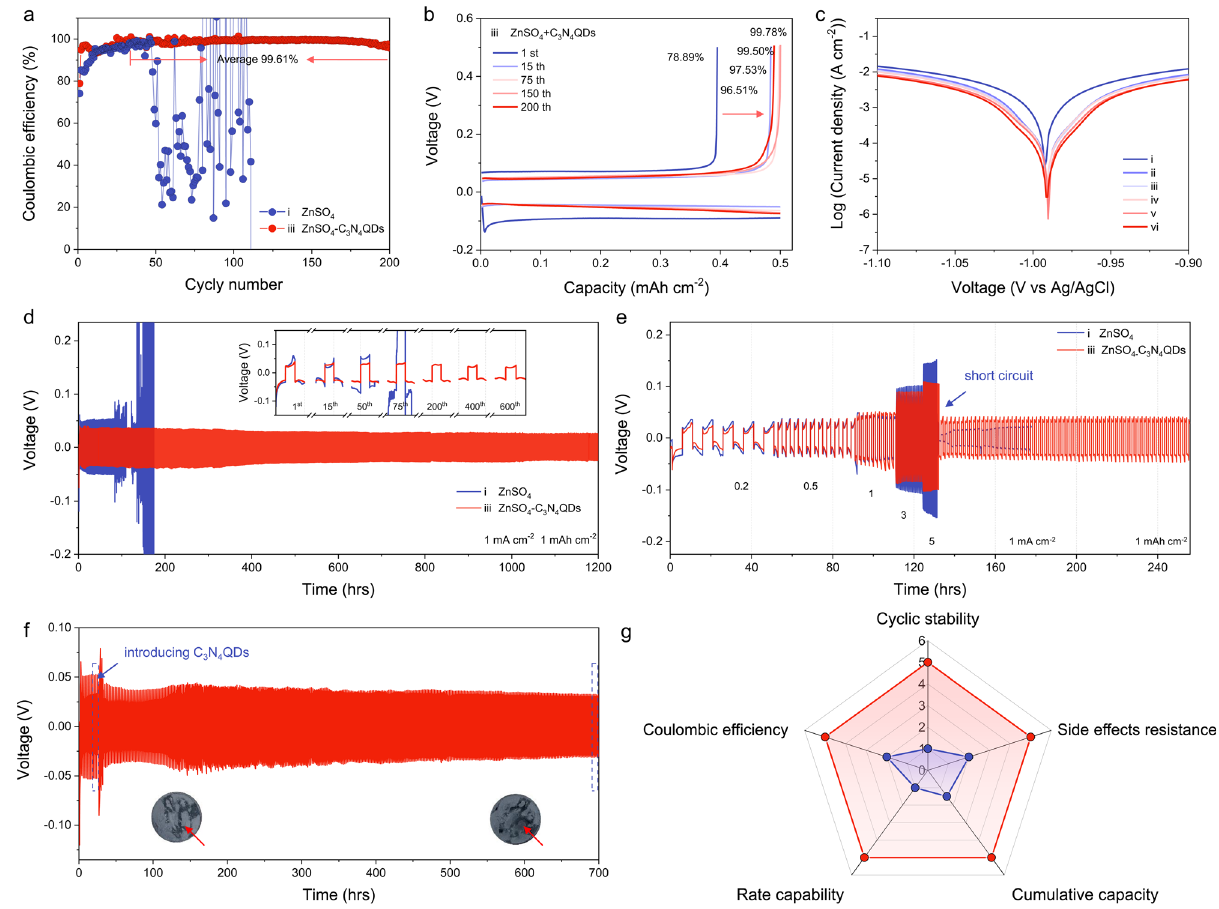
Fig. 5 | Electrochemical Zn/Zn 2+ reactions in ZnSO 4 and ZnSO 4 -C 3 N 4 QDs elec- trolytes. a Coulombic ef fi ciency measurements of Zn||SS cells under different electrolytes system and corresponding voltage pro fi les obtained in b 2M ZnSO 4 +0.5mgml − 1 C 3 N 4 QDs electrolytes at various cycles; c linear polarization curves of Zn foil in different electrolytes; d comparison of long-term galvanostatic Zn stripping/plating in the Zn||Zn symmetric cells and time-voltage pro fi les under 1mAcm − 2 with 1mAhcm − 2 ; e rate performance from 0.2 to 5mAcm − 2 ;